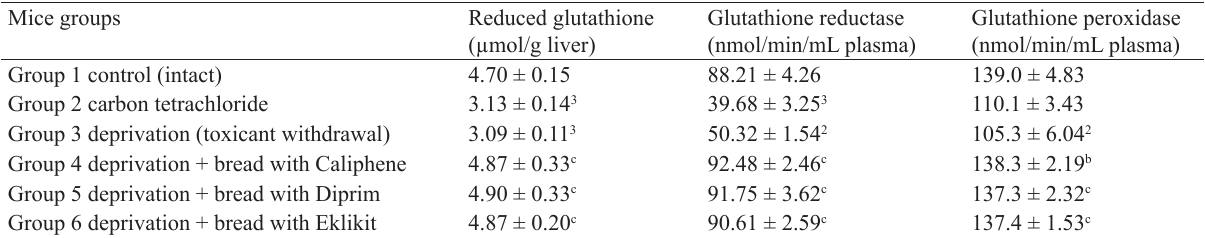
Table 4 Indicators of antioxidant liver and blood system of carbon tetrachloride intoxicated mice and their correction with extract- containing breads (M ± m)